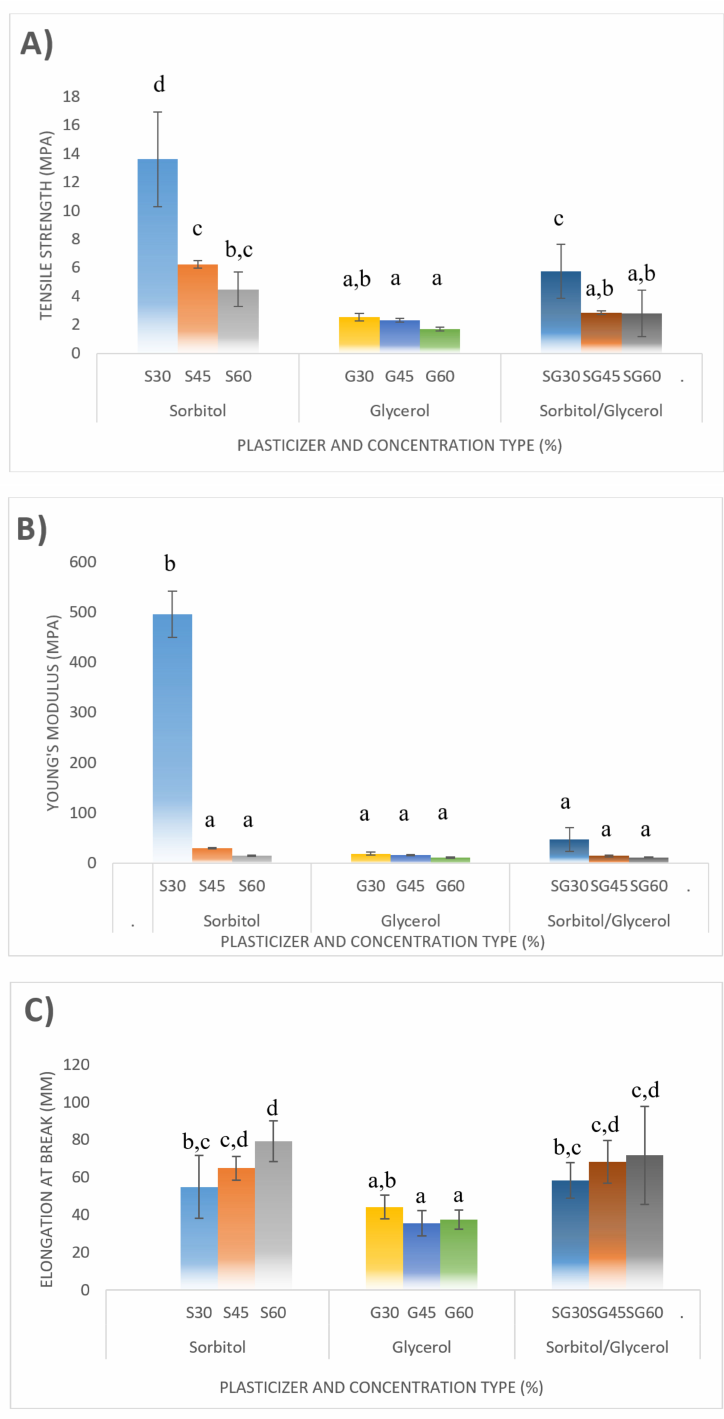
Figure 13. Tensile properties of corn starch biopolymer films. ( A ) tensile strength, ( B ) tensile modulus, and ( C ) elongation at break. Values with different letters (a–d) in the same column are significantly different ( p <